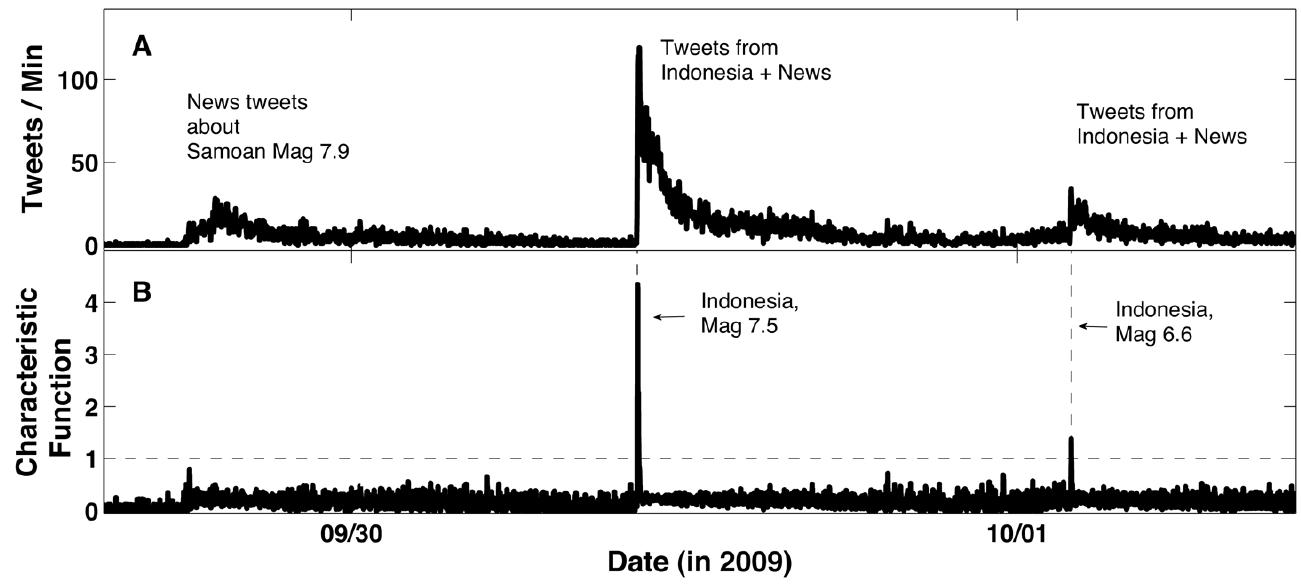
Figure 2. Several days of tweets spanning three events in September and October 2009. Our detector is tuned for sudden increases in Twitter activity, common for tweets submitted after felt shaking. When increases in Twitter activity results from news reports, as in the Samoan event, the tweet frequency increases more gradually and the characteristic function sometimes does not trigger. This is the preferred behavior because we are interested in tweets resulting from felt